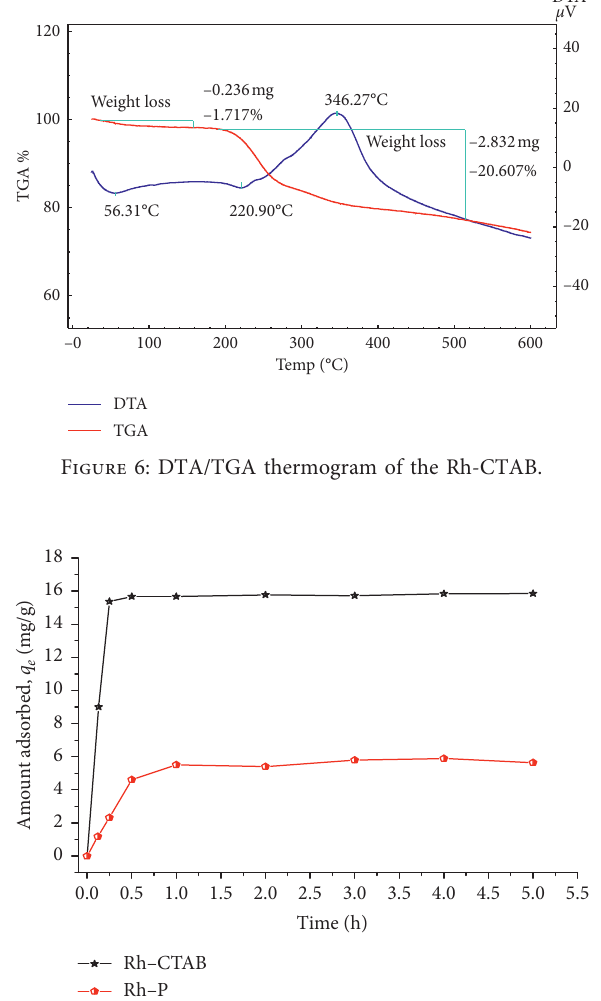
Figure 7: Adsorption kinetics of thymol onto the Rh-P and Rh-